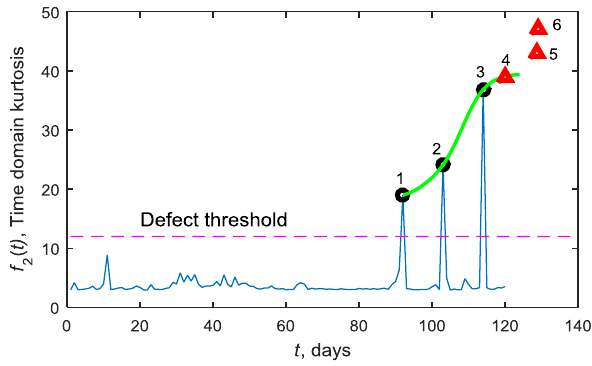
Figure 10. Kernel regression model and three-step-ahead prediction.